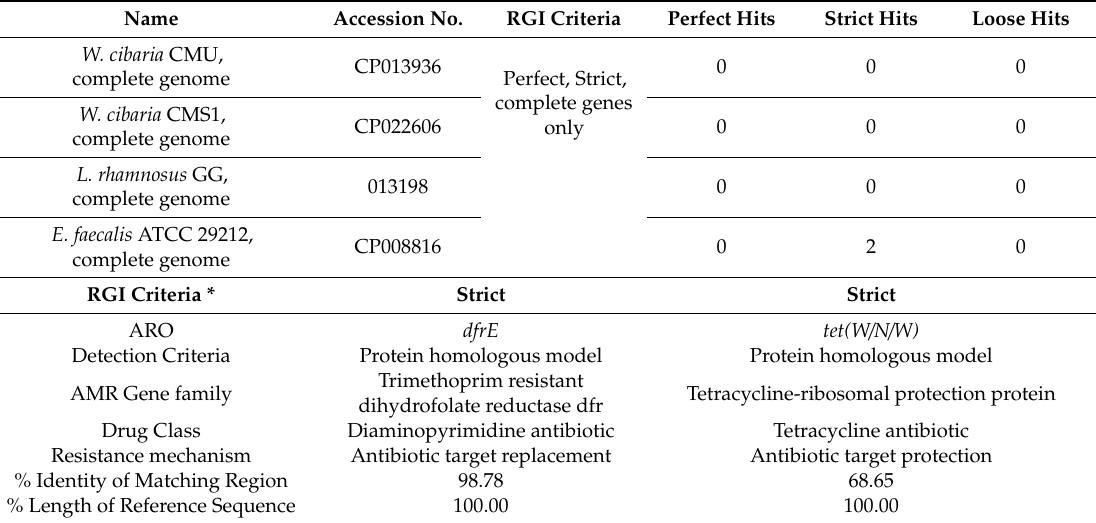
Table 4. The results of ARG analysis based on genome sequences